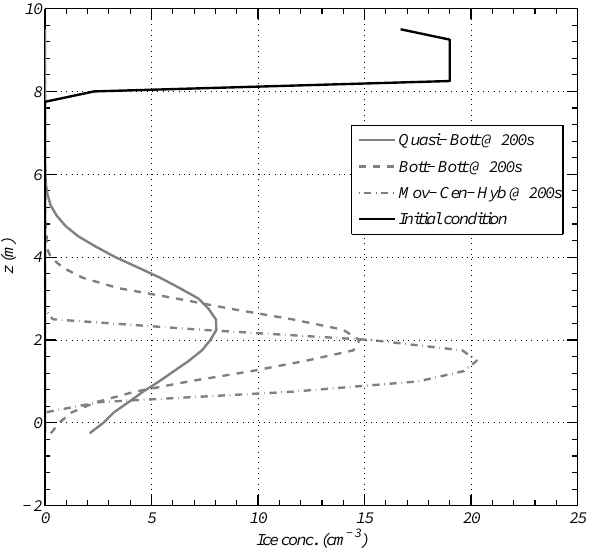
Fig. 4. Shows the initial ice concentration (black solid line) and the ice concentration for each of the model runs. It can be seen that the two single moment schemes are diffusive, while the double moment scheme is not.